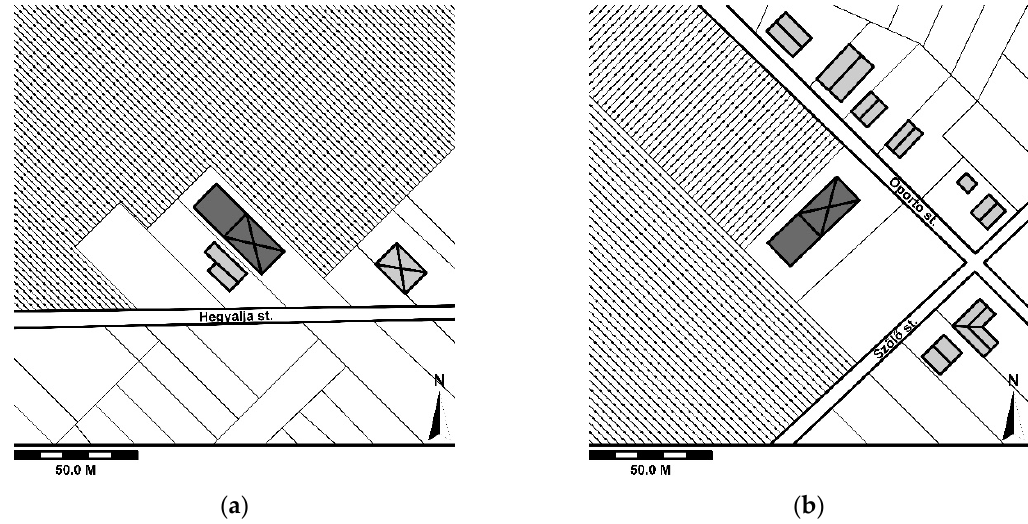
Figure 3. Construction sites with the new winery building (dark gray); neighbor buildings (light grey), vineyards (hatch). The X marks the pyramid with the UD tower in two different locations: ( a ) Site A—lower density with closer neighbors; ( b ) Site B—higher density with further neighbors